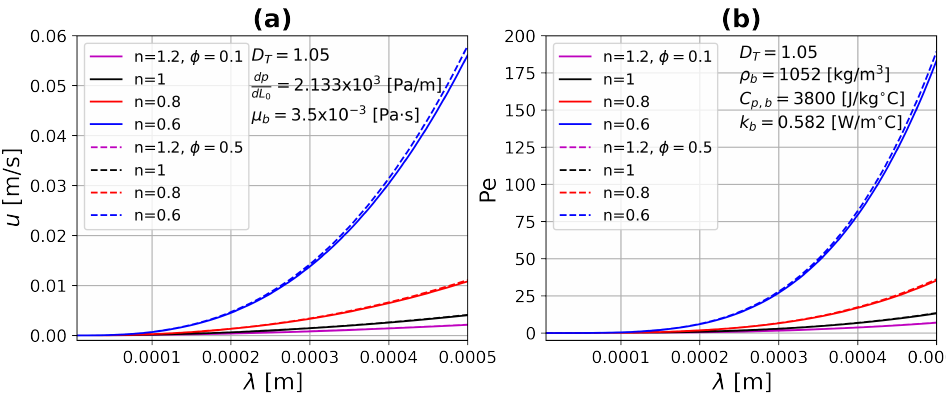
Figure 4. ( a ) Average velocity and ( b ) Peclet number as a function of capillary diameter for different values of the power-law index n . In a single microcapillary—continuous lines ( φ = 0.1), and dashed lines ( φ = 0.5).